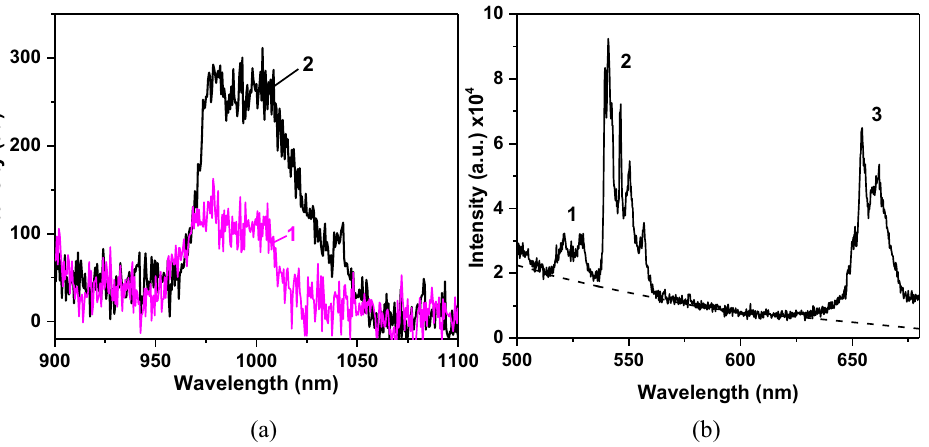
Figure 6: ( a ) Down - conversion emission spectra of phosphors ( 1 ) NaY 0.94 F 4 :Yb 3 + 0.03 ,Er 3 + 0.03 and ( 2 ) NaY 0.78 F 4 :Yb 3 + 0.2 ,Er 3 + 0.02 pumped by UV fl ashlight ( Figure 5b ) . ( b ) Visible ( down - shifting ) emission spectrum of phosphor NaY ( Figure 5a ) . Group of peaks 1 corresponds to the transition of excited ion Er 3 + : 2 H